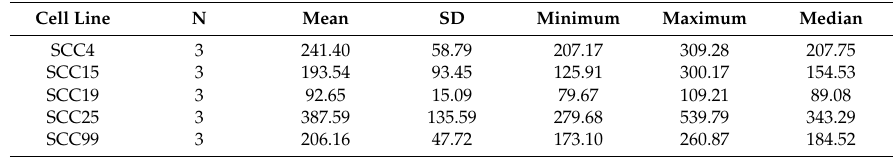
Table 2. Programmed death-ligand 1 (PD-L1) concentrations (pg / mL) in cell lysates of SCC4, SCC15, SCC19, SCC25, and SCC99.